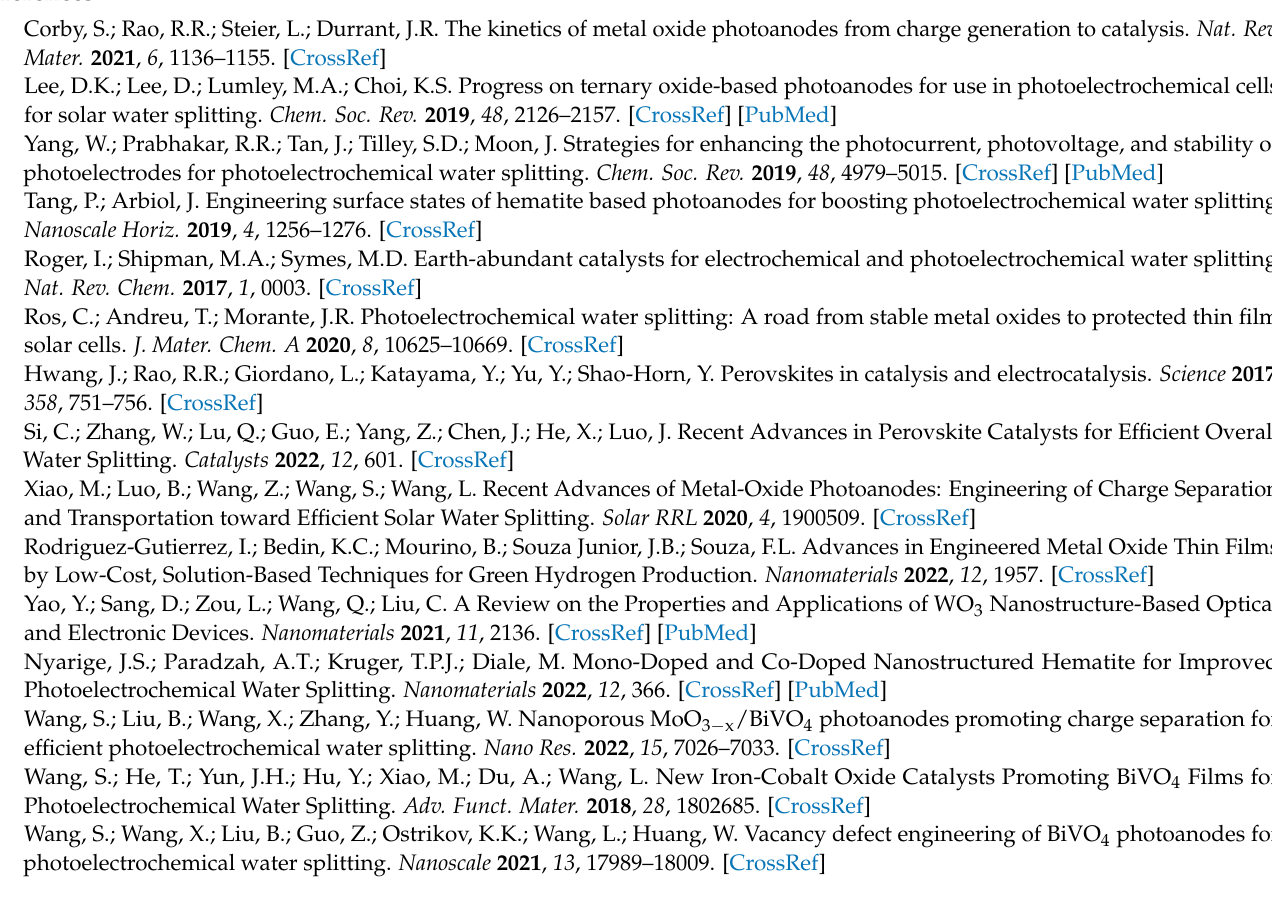
NaOH. Figure S7. Pt4f spectrum fitting. Figure S8: Impedance spectra of LFO/TiO 2 (1:100), LFO and LFO/Pt electrodes registered under illumination in deaerated 0.1 M NaOH and in O 2 -saturated (cid:16) i ( t ) − i (cid:17) ss 0.1 M NaOH. Figure S9: Linearized ln vs. time plots for LFO, LFO/Pt and LFO/TiO 2 at i 0 − i ss 0.55 V vs. RHE. Table S2: Charge transfer rate constants and recombination rate constants determined from transient photocurrent measurements for LFO, LFO/Pt and LFO/TiO 2 electrodes. Figure S10: Potentiostatic photocurrent transients registered during the illumination periods for the LFO/Pt electrodes at potentials of 0.850, 0.750, 0.550, 0.350 V vs. RHE in O 2 -saturated 0.1 M NaOH solution. Table S3. Comparison of the photocurrent densities with the literature data. Reference [67] is cited in the supplementary